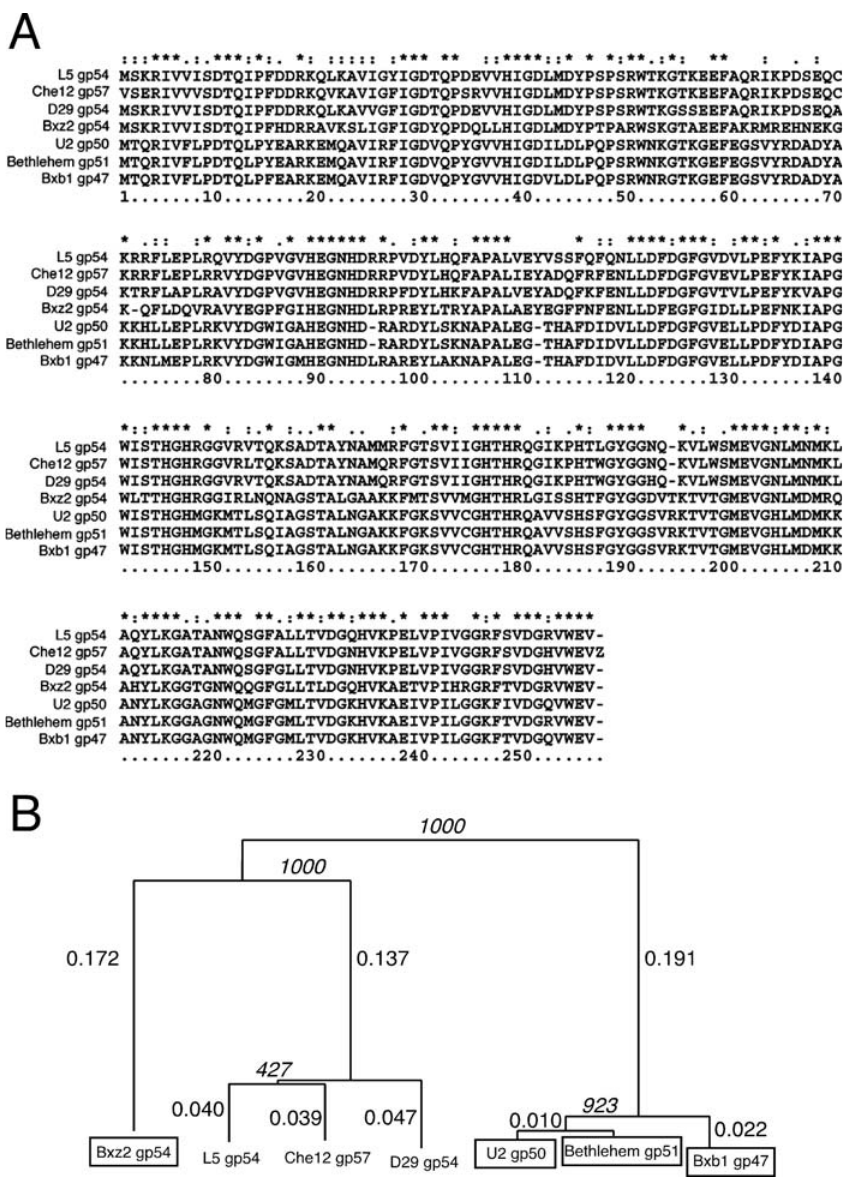
Figure 3. Sequence Alignment of Bxb1 gp47 and Its Homologs (A) A BLAST search identified proteins of mycobacteriophages U2 (gp50), Bethlehem (gp51), L5 (gp54), D29 (gp54), Che12 (gp57), and Bxz2 (gp54) with similarity to Bxb1 gp47. Multiple sequence alignment of these proteins was performed using ClustalW (identical residues indicated by an asterisk [*]) and the phylogenetic relationship (B) represented using NJPLOT; branch lengths and bootstrap (italicized) values are indicated. The proteins encoded by phages that encode a serine integrase (Bxz2, U2, Bethlehem, and Bxb1) are boxed; all others (L5, D29, and Che12) encode a tyrosine integrase. DOI: